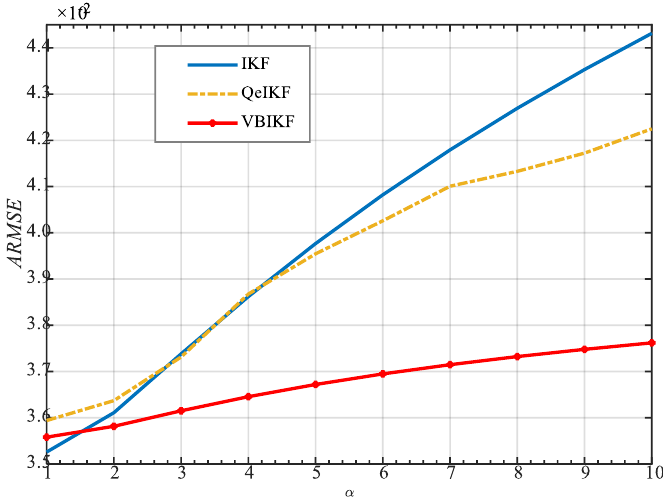
 with 110   . w  of different accuracies. w